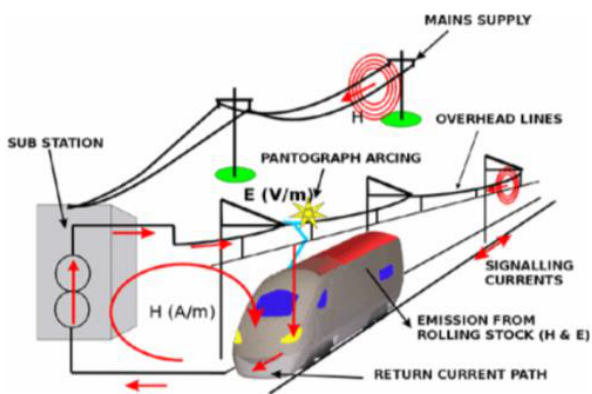
Figure 21. Electromagnetic interference (EMI) occurrence places in ERPS [134].